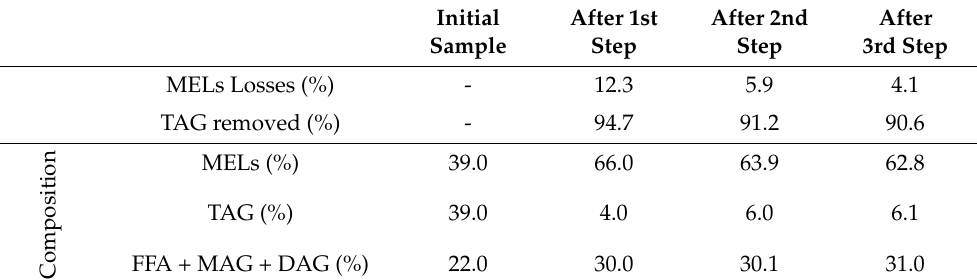
Table 3. Cumulative MELs and contaminant losses and composition of combined top phases for the consecutive step of MEL purification with MeOH by solvent-selective